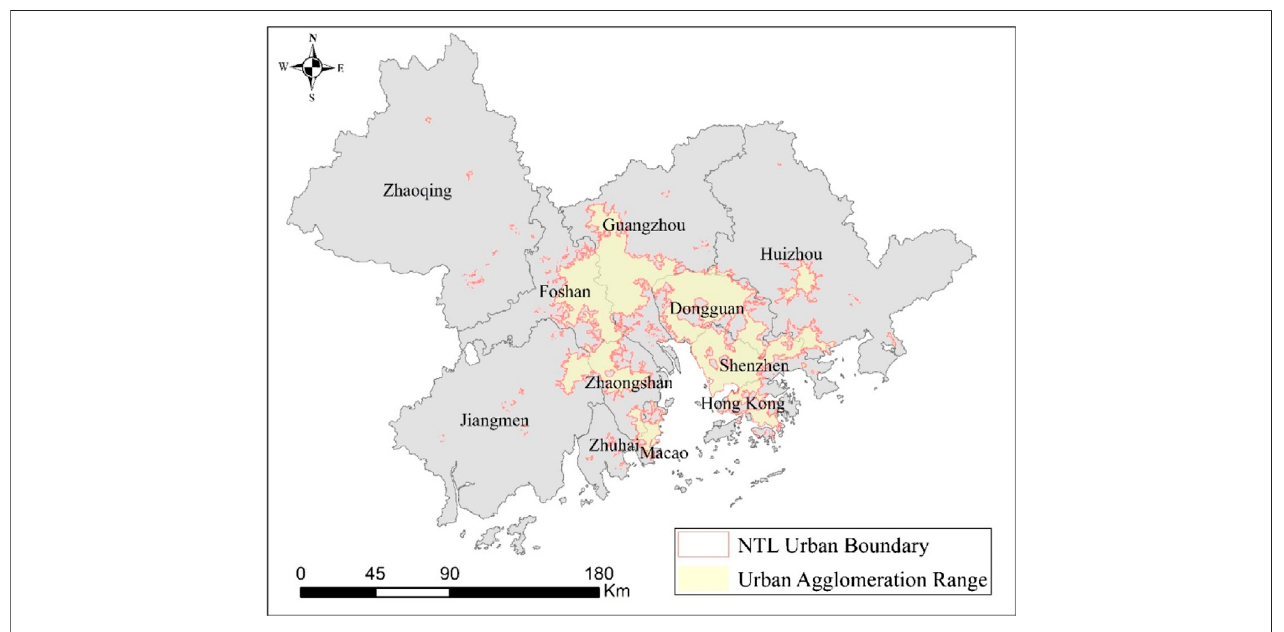
FIGURE 4 | GBA urban agglomeration boundary delineated using NTL data.